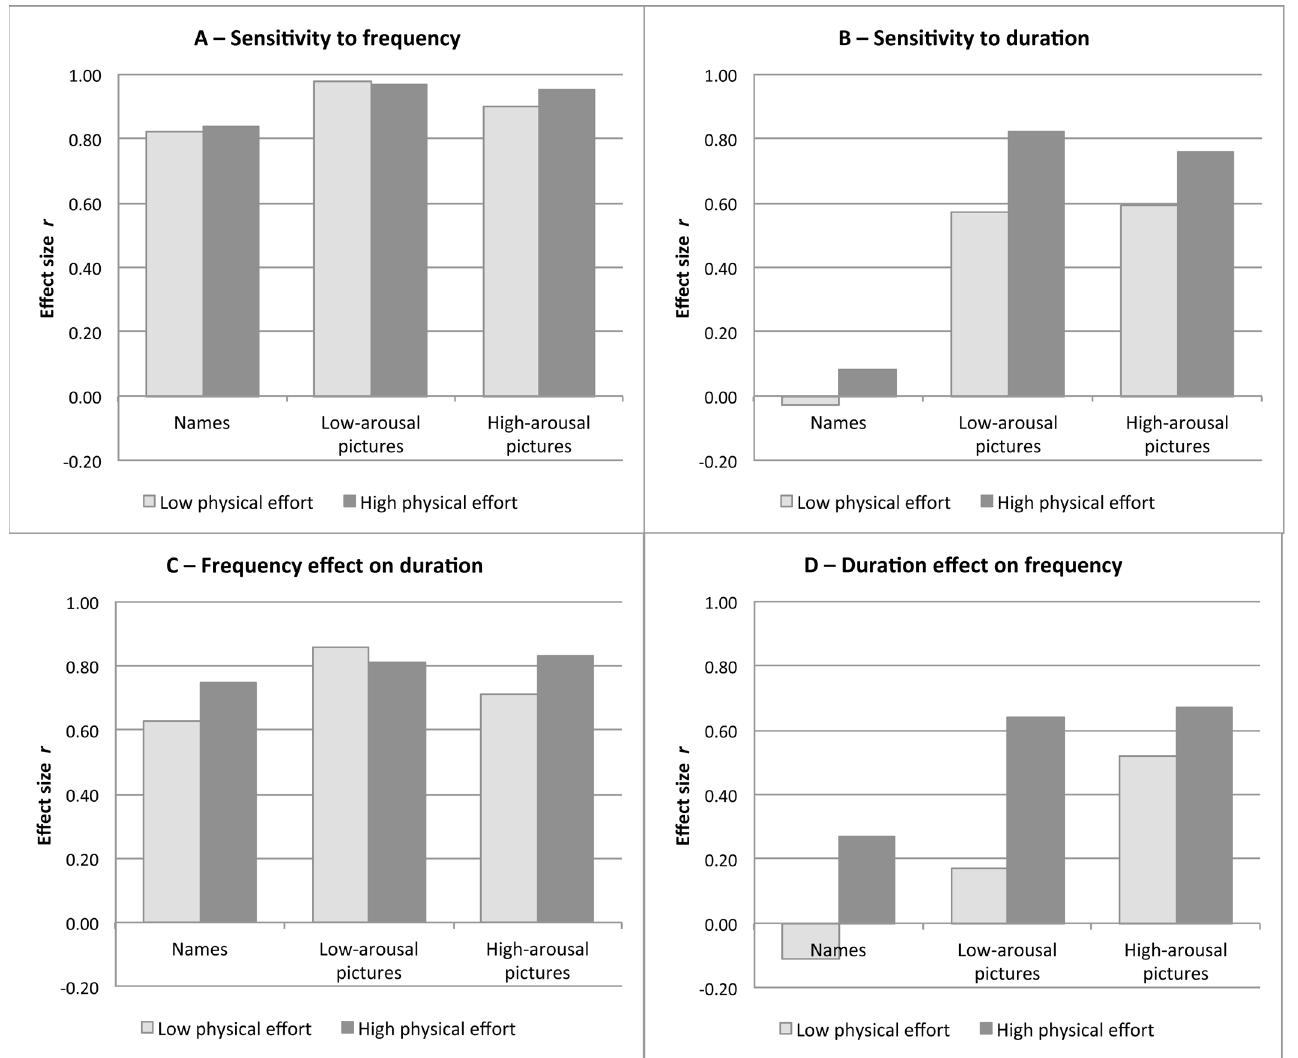
Fig 1. Effect size r of the regression coefficients in the multilevel regression analyses separately for the different stimulus types processed under low and high physical effort. A) Sensitivity to stimulus frequency; B) Sensitivity to stimulus duration; C) Influence of stimulus frequency on duration judgments; D) Influence of stimulus duration on frequency judgments. The figure shows generally large effect sizes for the sensitivity to frequency and for the frequency effect on duration in every attention condition. However, sensitivity to duration was obtained only in the picture conditions with especially large effects when pictures had to be processed under high physical effort. The duration effect on frequency was low for names in both effort conditions and for low-arousal pictures processed under low effort (and somewhat larger for high-arousal pictures under low effort). For both picture types processed under high effort a large duration effect on frequency was